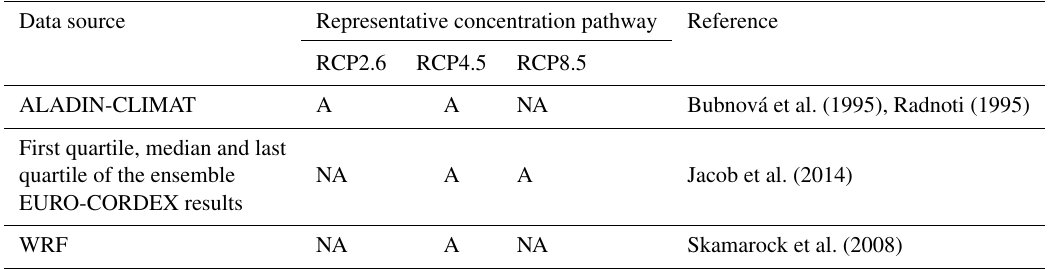
Table 2. Regional climate projections available in the DRIAS portal (A: available; NA: not